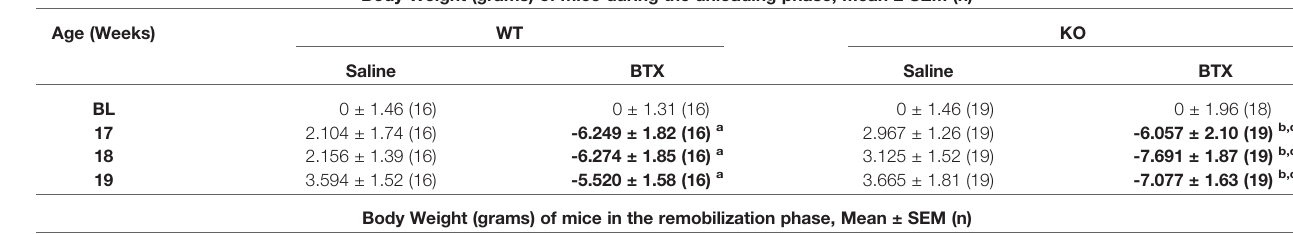
Body Weight (grams) of mice during the unloading phase, Mean ± SEM (n)